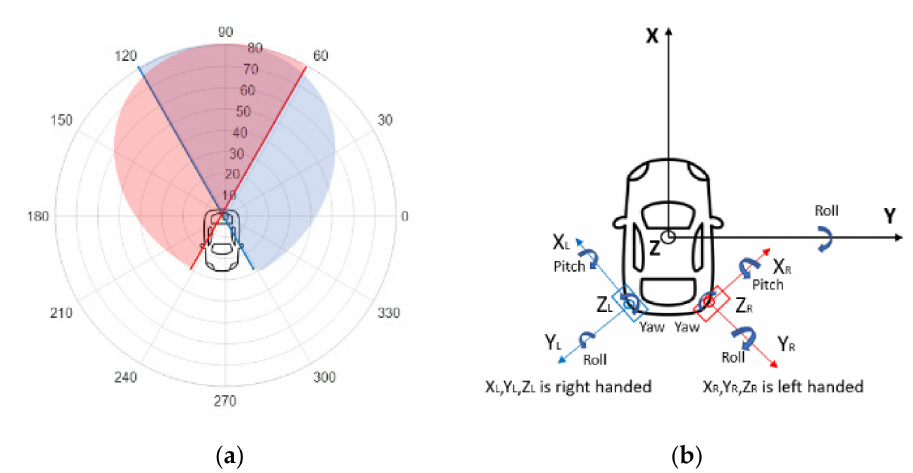
Figure 3. ( a ) Radar system FOV: 10 m per range grid, 30 ◦ per angle grid; ( b ) radar alignment illustration. The signals from two radars are collected using CAN bus messages simultaneously.